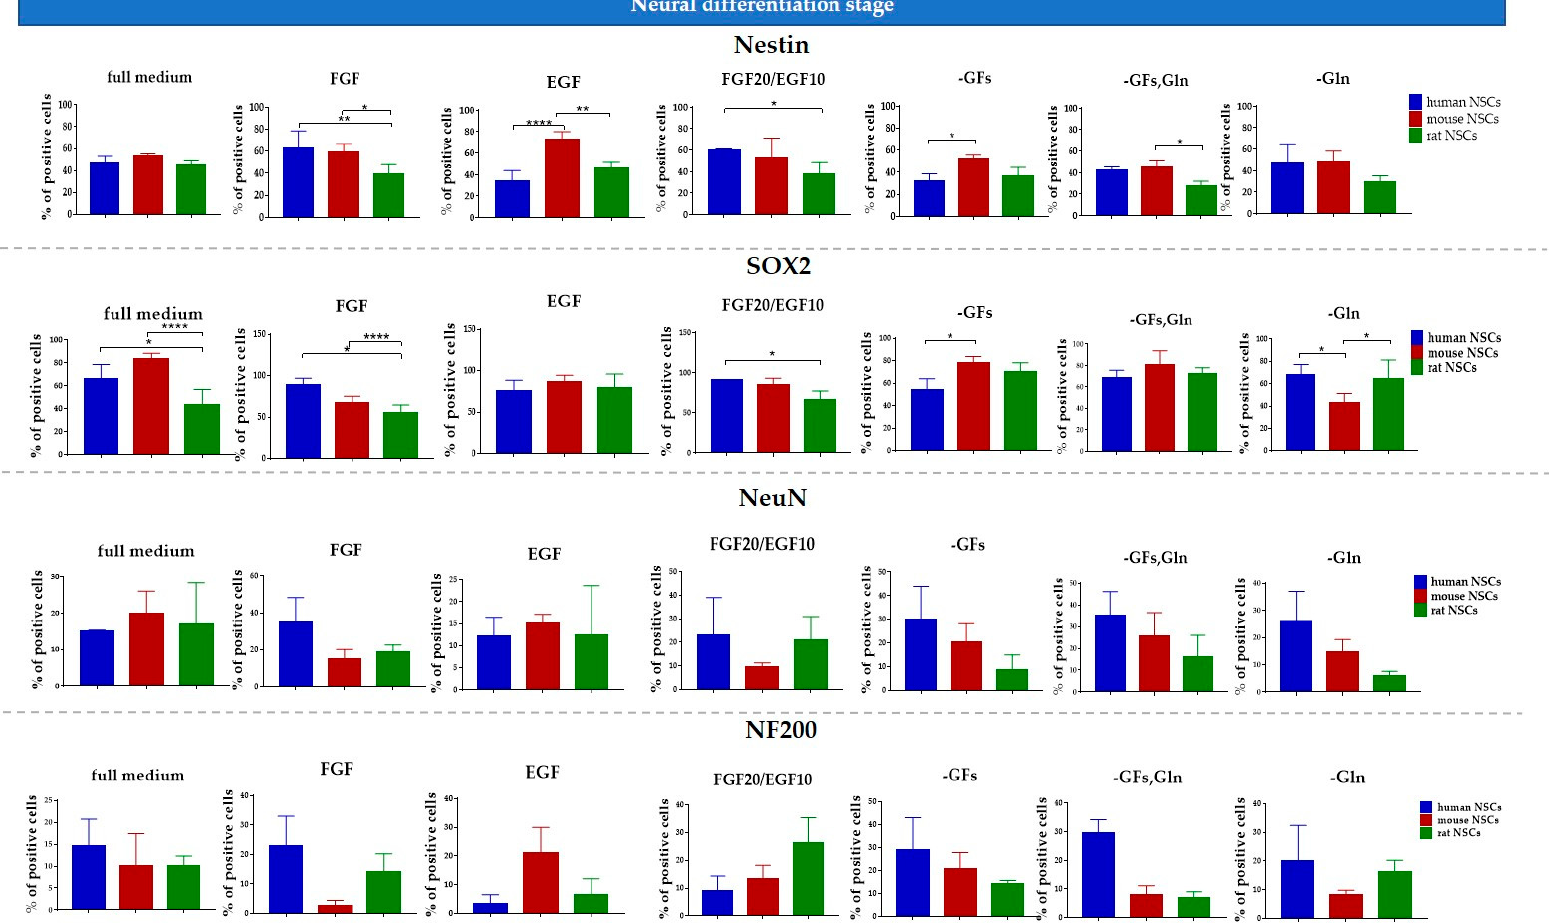
Figure 14. Neural differentiation of human NSCs in 2D culture. Quantitative analysis of neural (Nestin, SOX2) and neuronal (NeuN, NF200) markers. Cell culture conditions: 5% O 2 , 5% CO 2 , 37 °C; N = 3. The results are presented as mean values of three experiments ± SEM. The differences were considered statistically significant when the p -value < 0.05. Statistical significance level: * for 0.01 < p < 0.05, ** for 0.001 < p < 0.01 and **** for p < 0.0001.